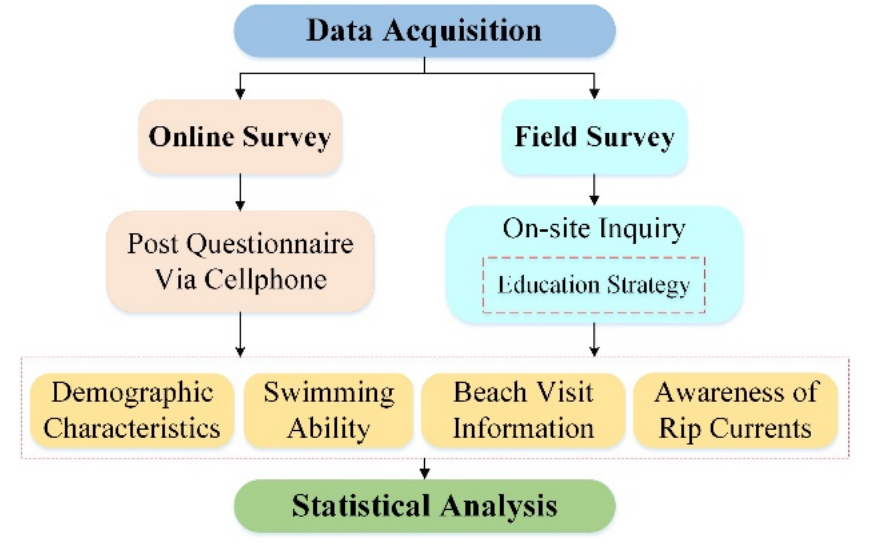
Figure 2. Flow chart of the survey methods.